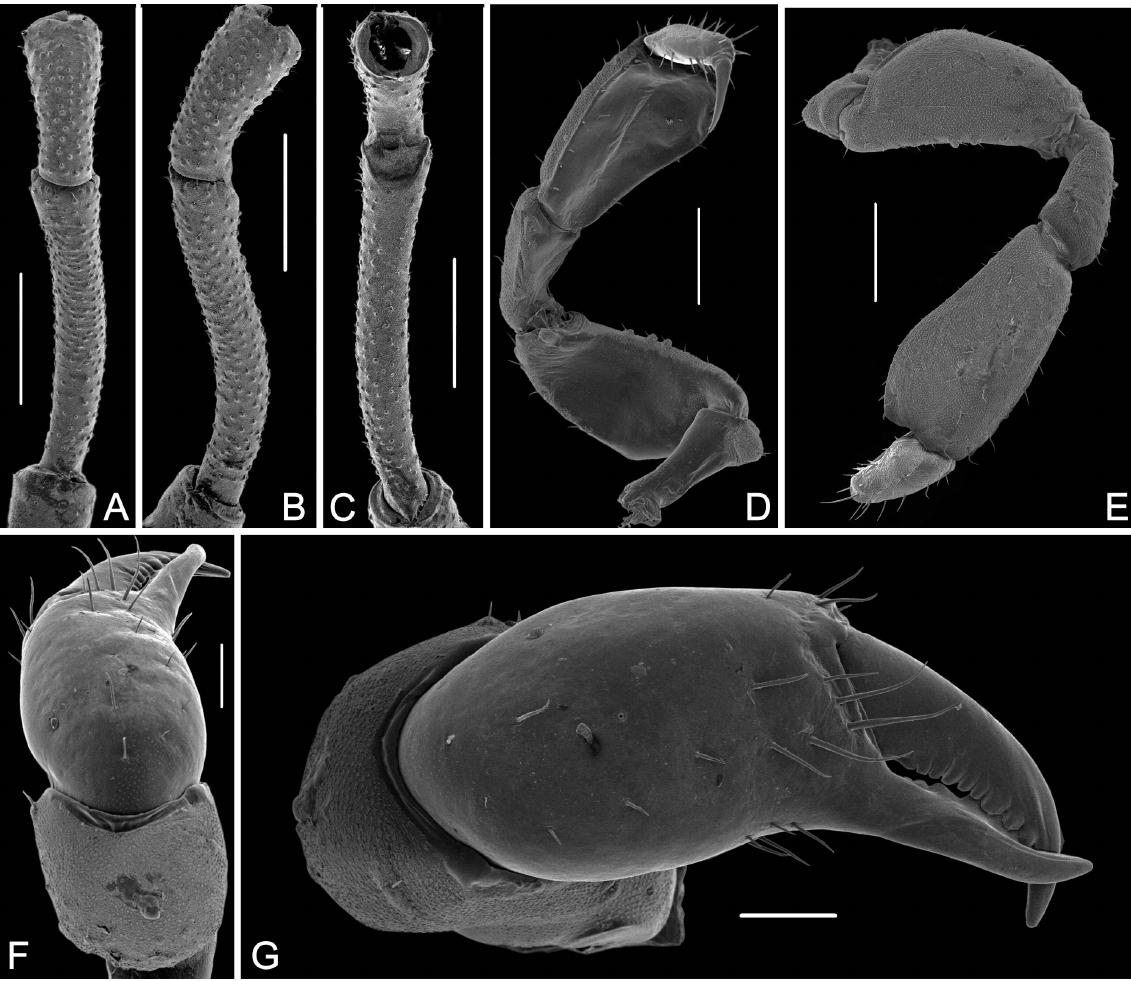
Fig. 7. Libitia cordata (Gervais, 1844), ♂ (ICN-AO 1040). A–C . Left femur IV, dorsal, prolateral and ventral view, respectively. D–E . Right pedipalp, ventral and dorsal view, respectively. F–G . Left chelicera, dorsal and frontal view, respectivelly. Scale bars: A–C = 1 mm, D–E = 500 μm; F–G = 200